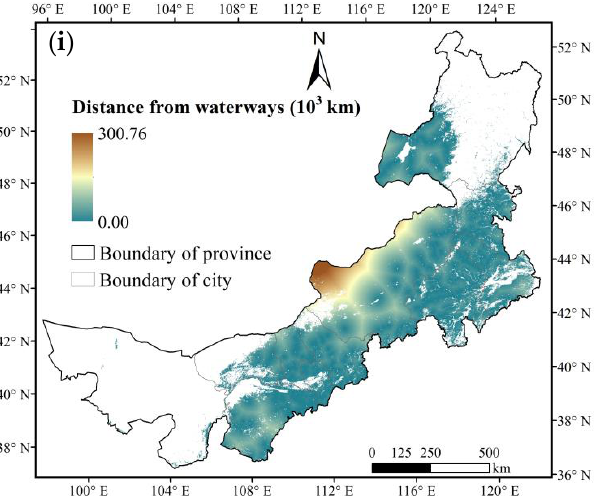
Figure 3. Spatial distribution of ( a ) slope, ( b ) NDVI, ( c ) precipitation, ( d ) temperature, ( e ) GDP, ( f ) population density, ( g ) distance from roads, ( h ) distance from railways, and ( i ) distance from waterways in Inner Mongolia.